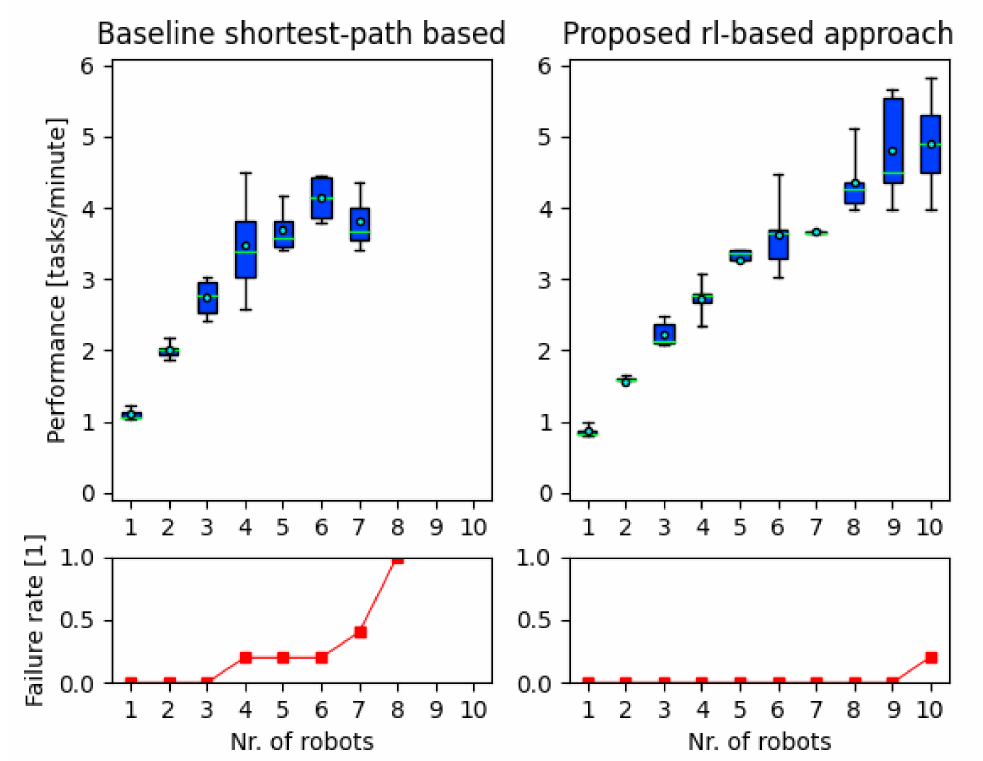
Figure 10. Performances of the proposed and the baseline approach. Above: the performances calculated according to Equation (5). Below: the proportion of tests in which a multi-AMR system failed to finish given tasks due to severe conflicts between the